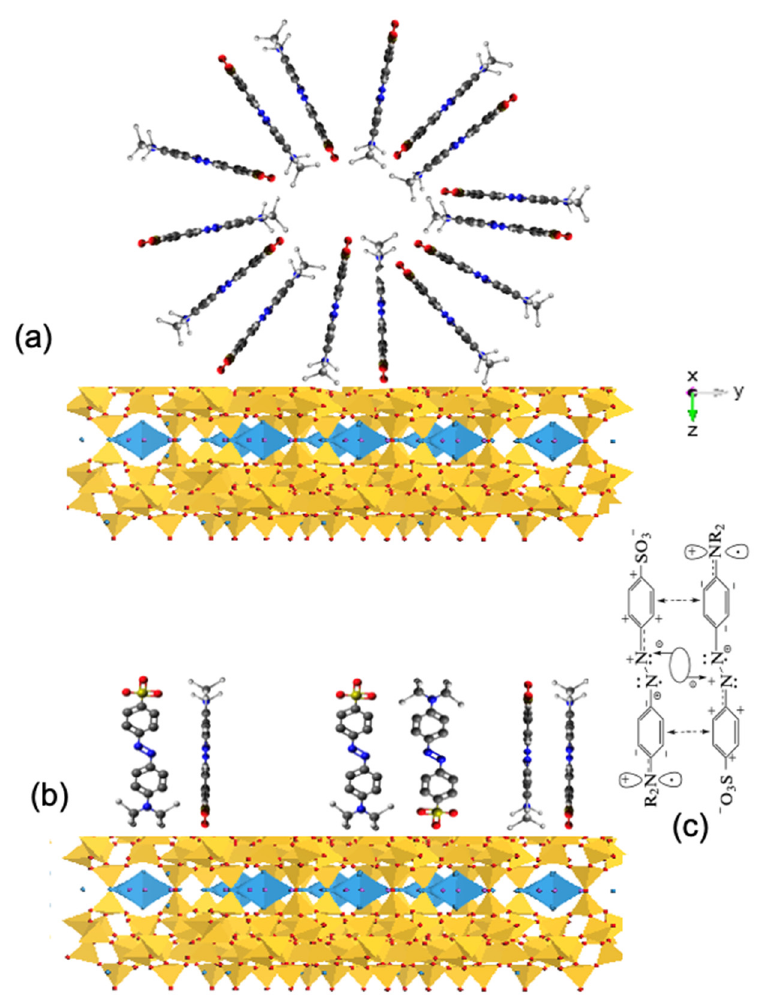
Figure 8. Hypothetical aggregations of MO ( a ) and dimer sorption of MO ( b ) on clinoptilolite surfaces and illustration of dimer interactions ( c ).